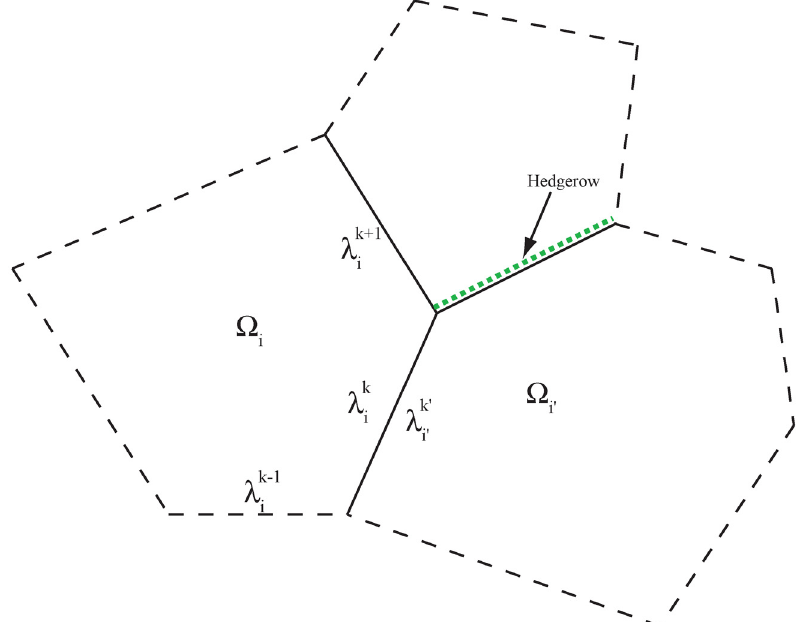
Fig 1. Example of a landscape made of three 2D patches. Solid lines correspond to interior edges (= corridors), and dashed lines to exterior edges with no 1D dynamics. Interior edges may be asymmetrical, for instance with a wall on the one side and a hedgerow on the other. The indices k are taken anti-clockwise.